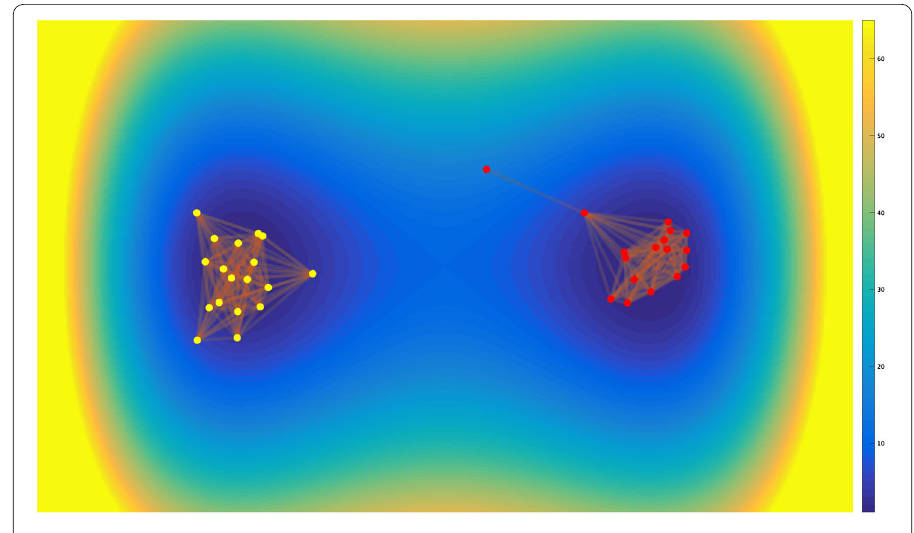
Figure 1 An example of a suitability landscape in form of the double well potential V ( x , y ) = ( x 2 – 1) 2 + y 2 is shown here. The heat map colours, ranging from dark blue to yellow, indicate low to high values of the landscape. This landscape is characterized by two attractive areas that are centered at the two local minima and a barrier between them. We consider n = 35 agents and the interaction radius r = 1. Adopters of the innovation are represented by red dots, whereas non-adopters are shown as yellow